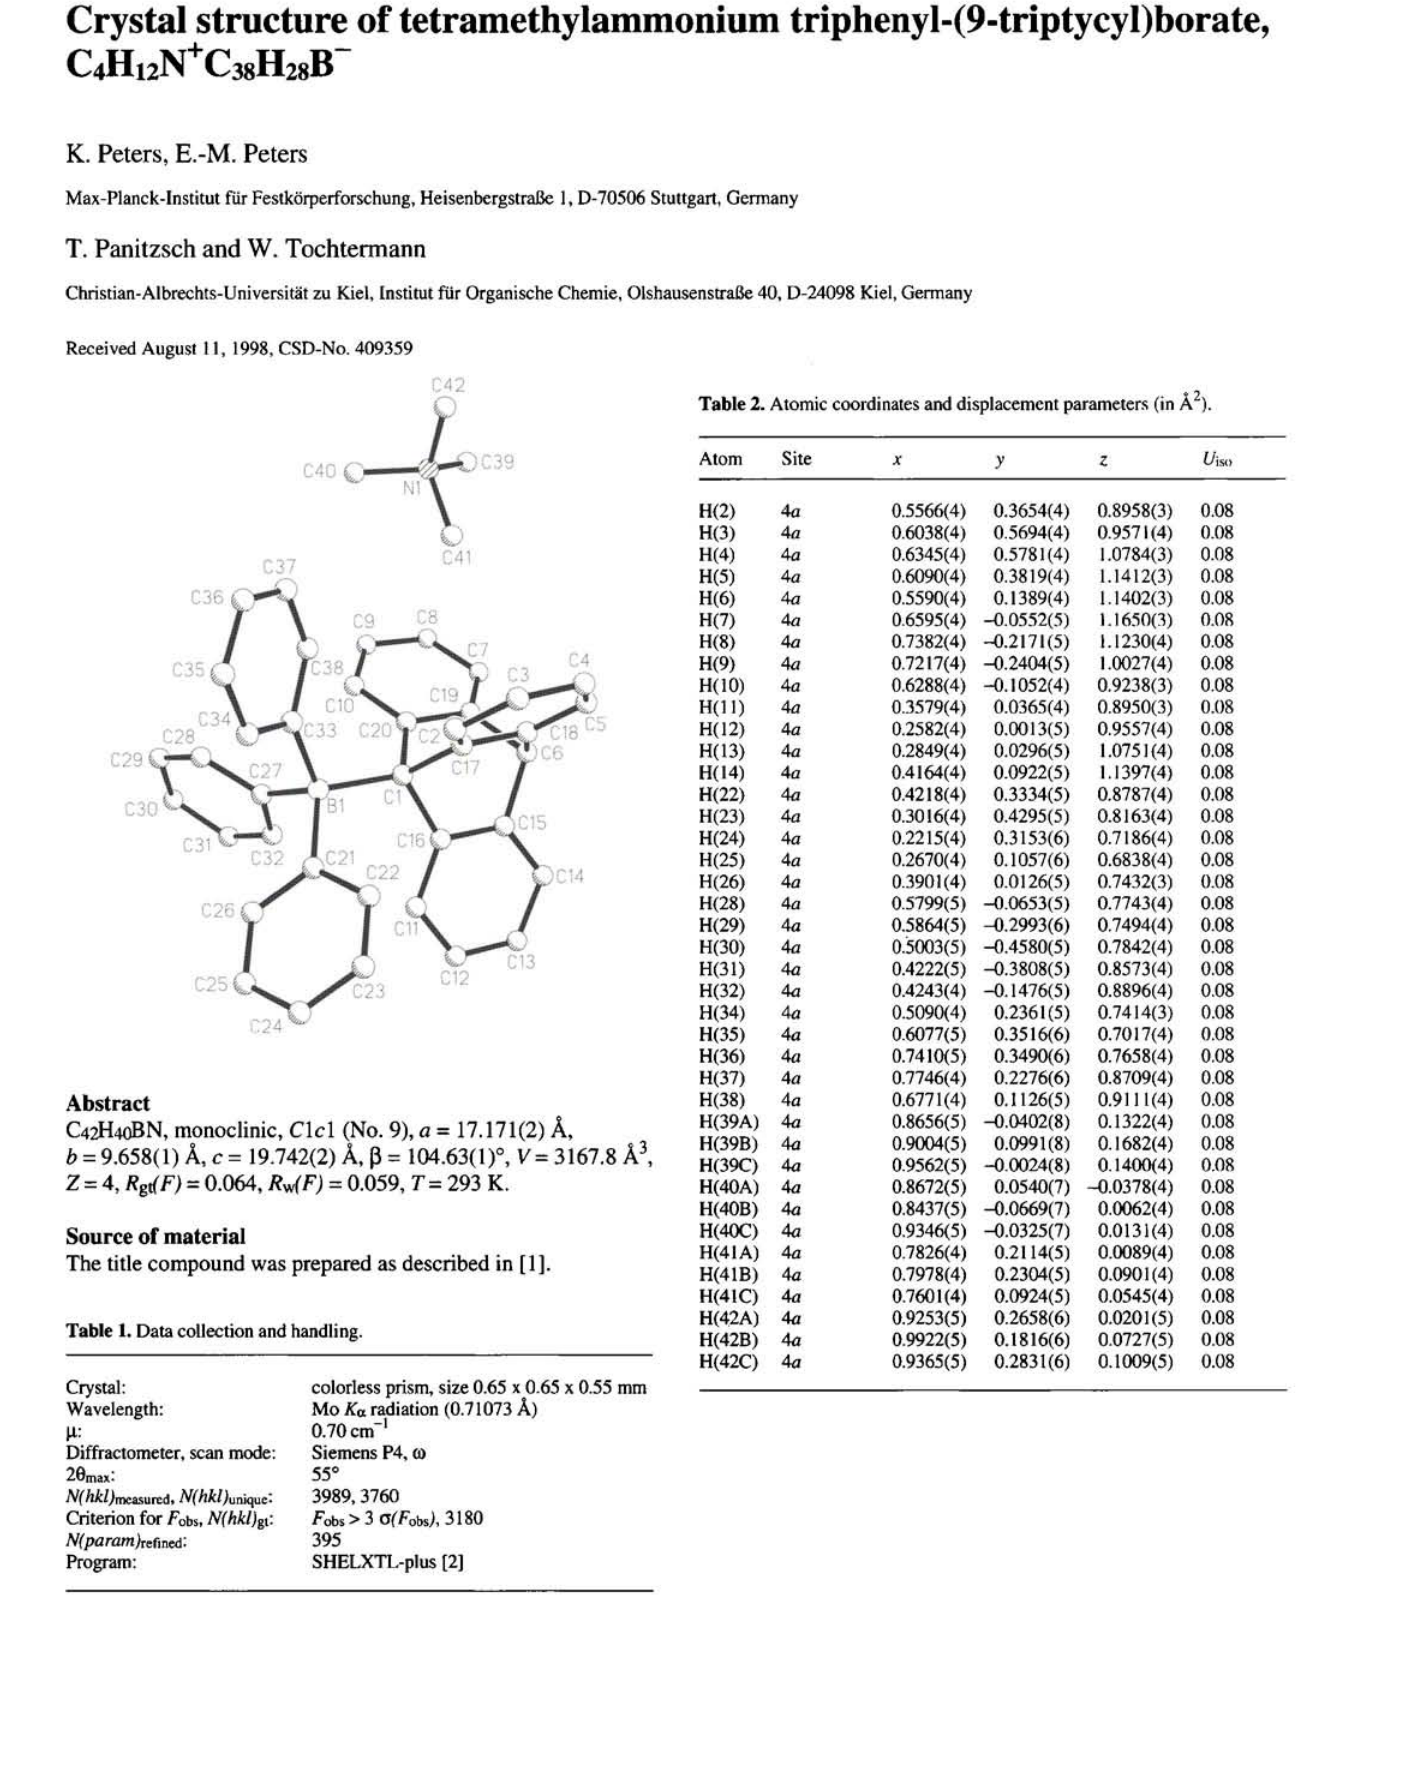
Table 2. Atomic coordinates and displacement parameters (in A